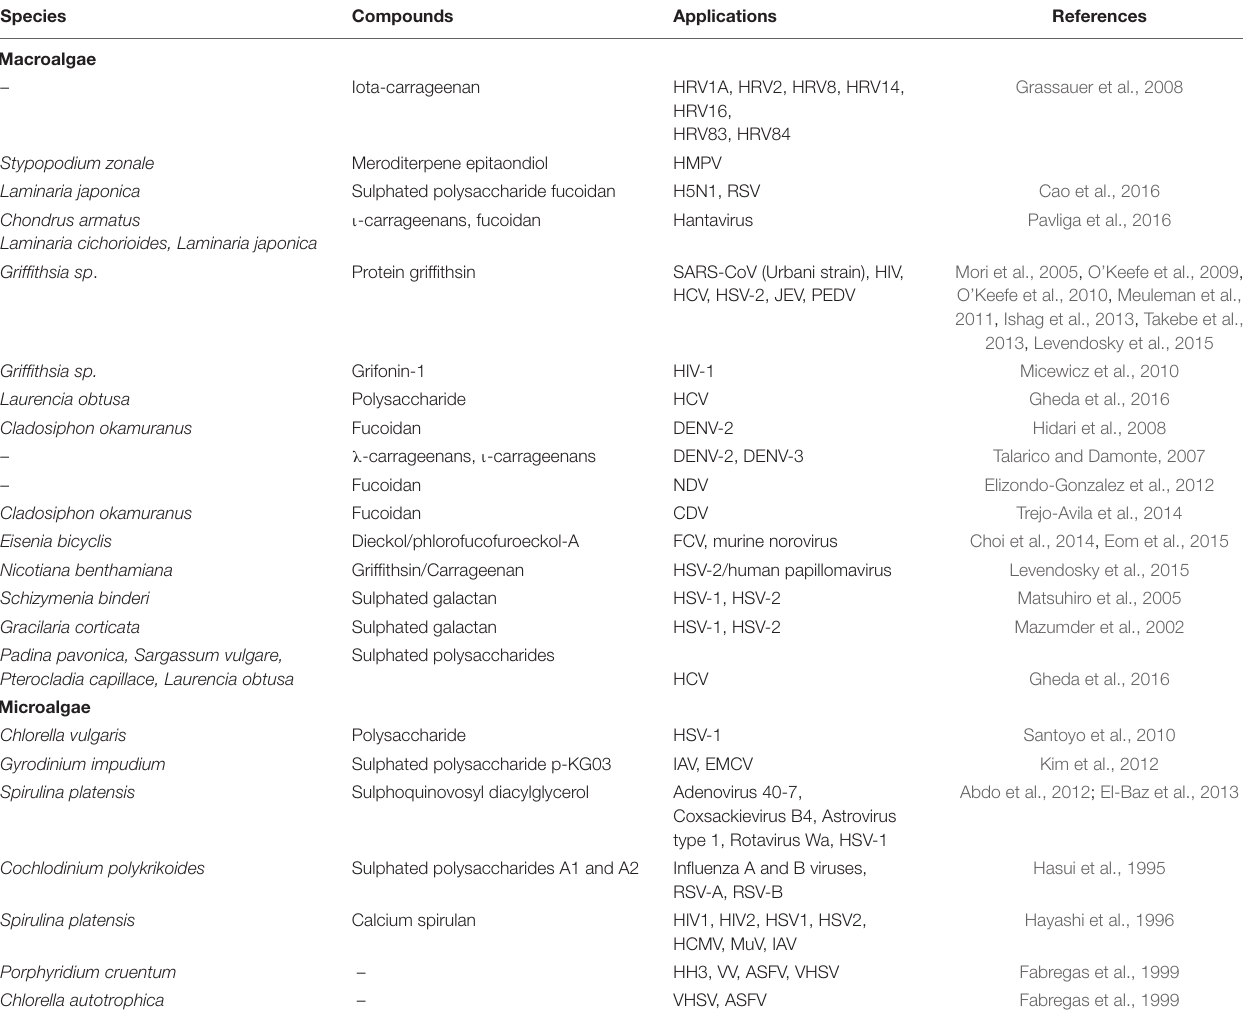
TABLE 1 | Species and compounds from algae used as